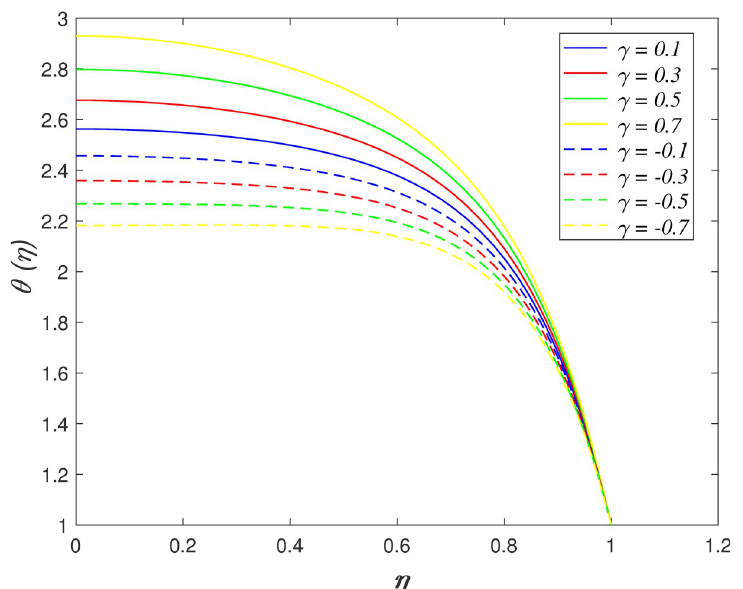
Fig 19. Impact of γ on